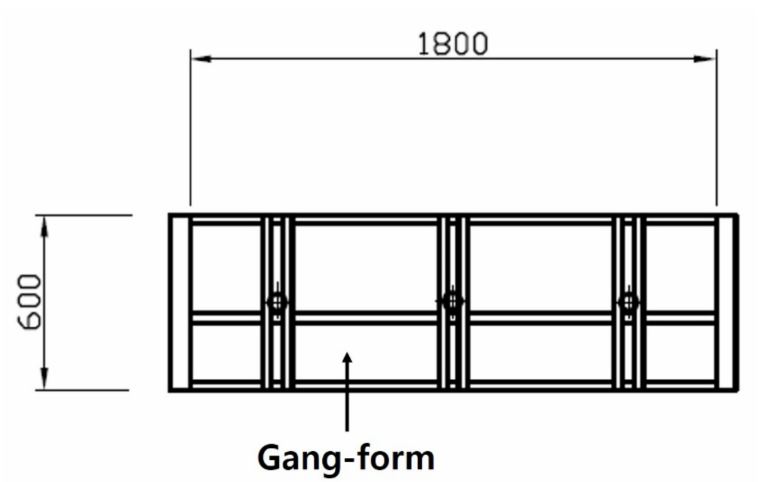
Figure 4. Sketch of the